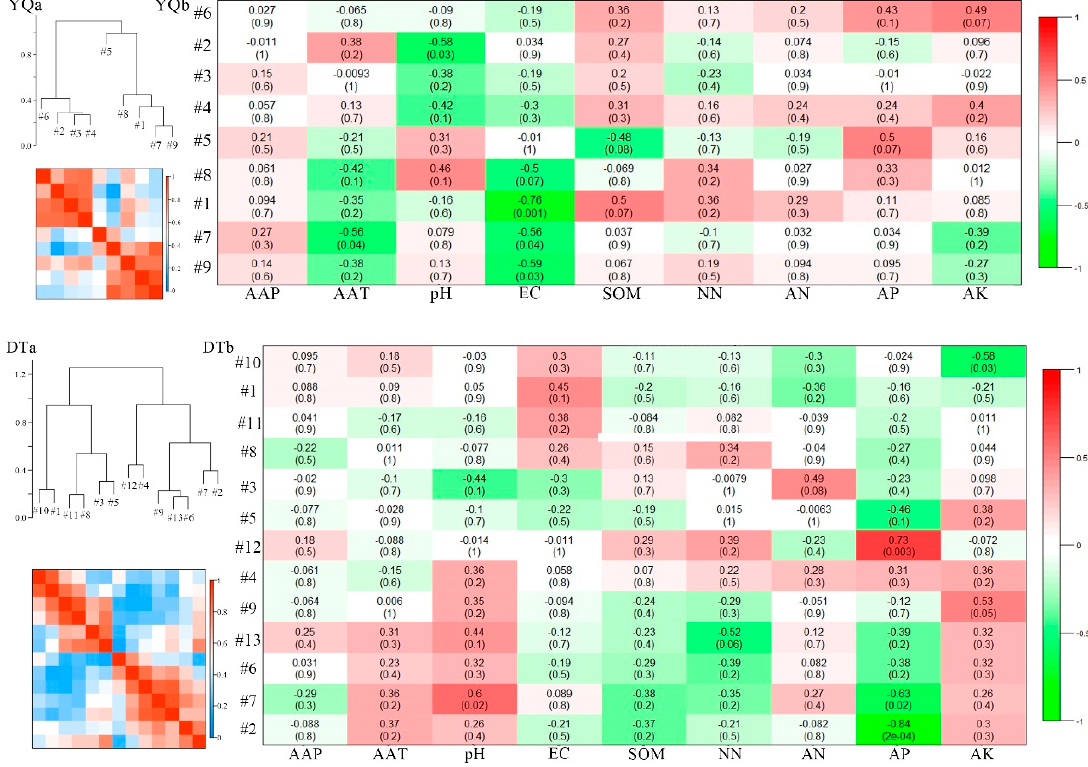
Figure 7. Correlations and heatmap of module eigengenes of the four networks ( a ). Correlations between the signal intensity of a module and each soil characteristic for the four networks ( b ).